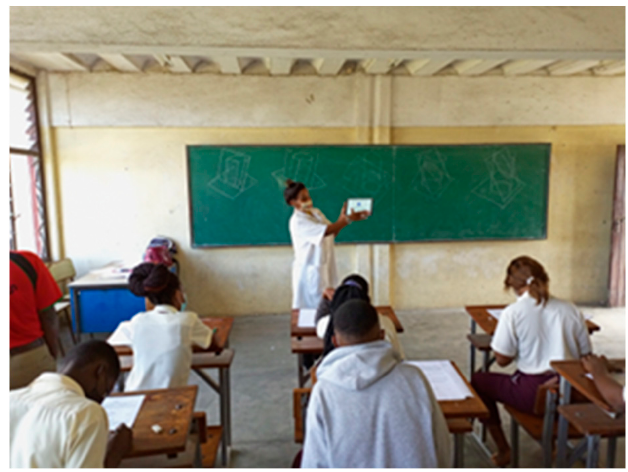
Figure 5. During presentation using the dynamic software GeoGebra.